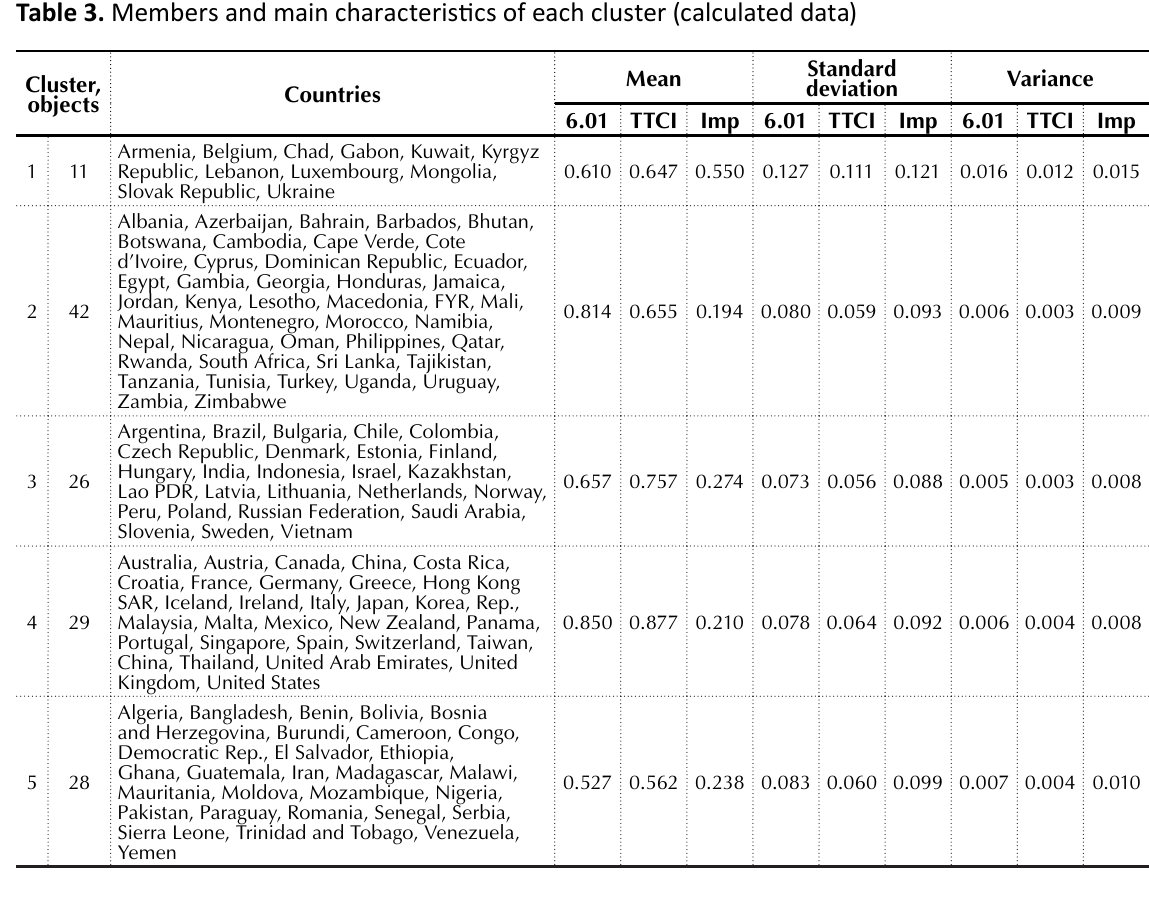
Figure 3. Cluster means